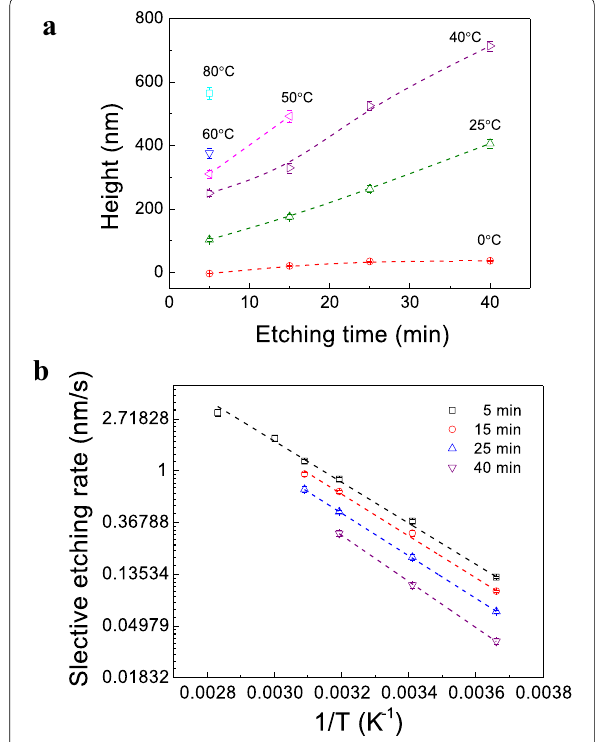
Figure 17 Temperature-dependent friction-induced selective etching on Si(100) surface [71]: ( a ) Correlation of fabrication height and etching time under various etching temperature during friction-induced selective etching in KOH solution, ( b ) The variation of the selective etching rate with reciprocal temperature